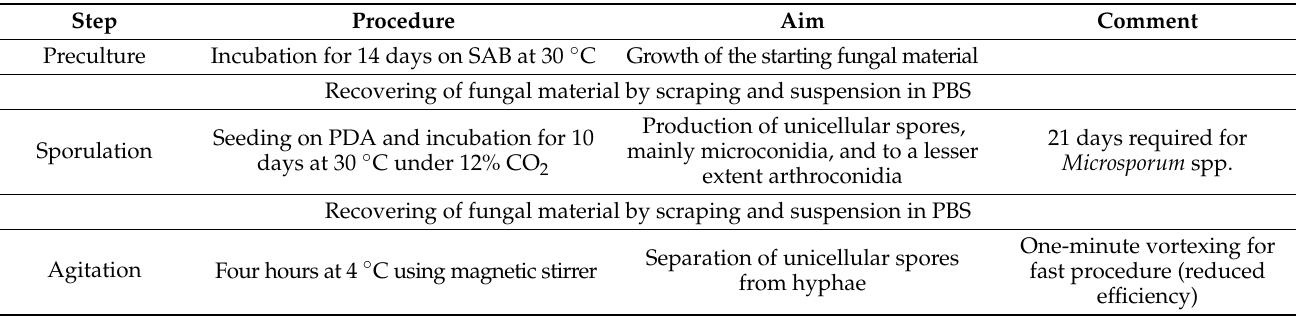
Table 5. Recommendations for a standardized procedure for the production of infective spores useable as inoculum in in vitro and in vivo experimental